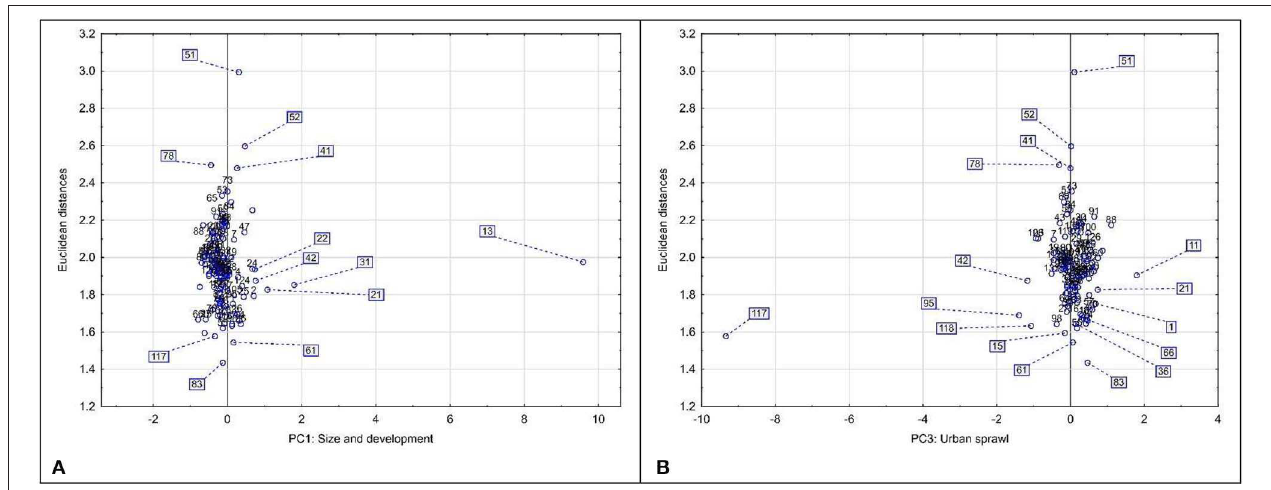
FIGURE 8 | Scatter plots of urban sustainability indices and climatic departures. (A,B) show scatter plots of climatic departures from current normals and the city size and development index (PC1), and the urban sprawl index, respectively. A list of names and ID numbers of Mexican cities is provided in Table A2